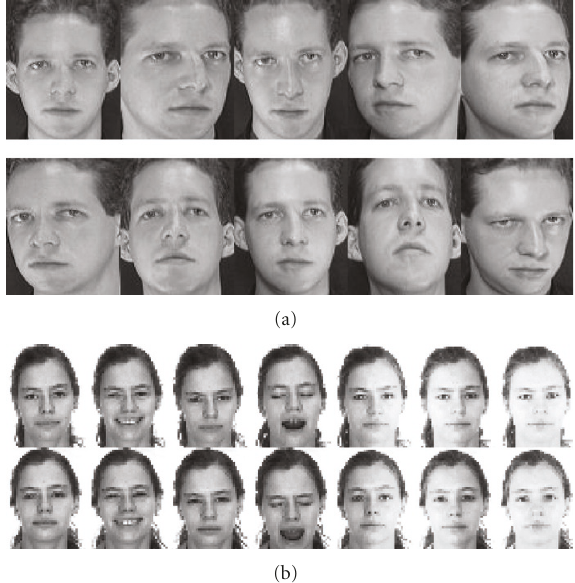
Figure 3: Some sample images in the (a) ORL and (b) AR face